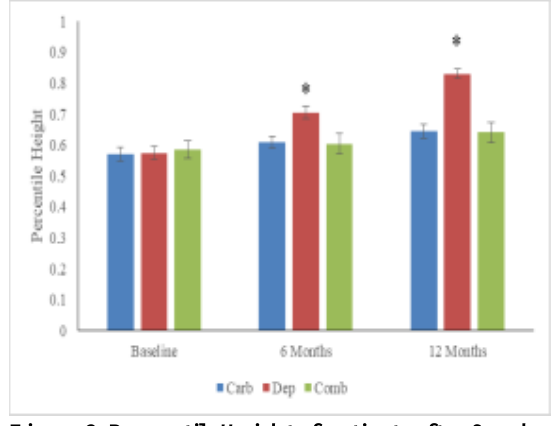
Figure 2. Percentile Height of patients after 6